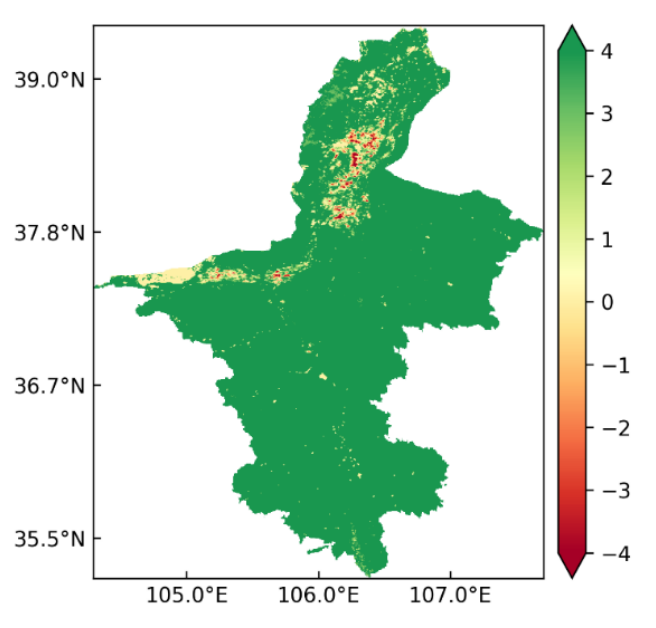
Figure 6. Spatial distribution of ET trends in Ningxia from 2001 to 2020.